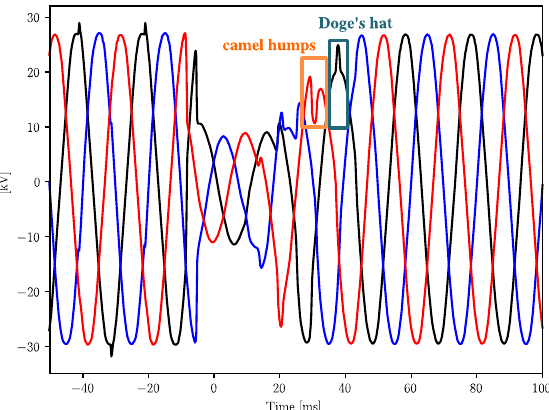
Figure 2. False event due to VTs saturation: voltage waveforms with the characteristic camel humps and Doge’s hat patterns.